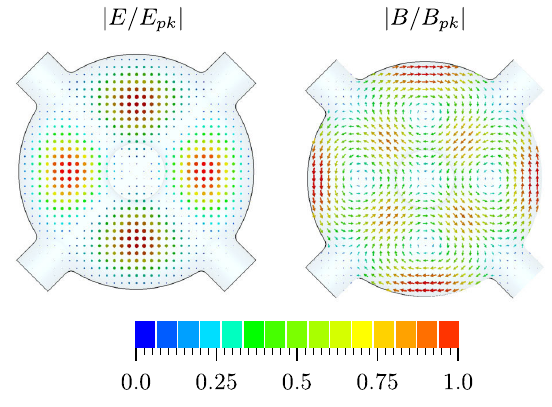
FIG. 10. Electric and magnetic field distribution of the quadru- pole mode in the transverse plane. The cavity is equipped with ports at the low field regions potentially suitable for damping lower and higher order